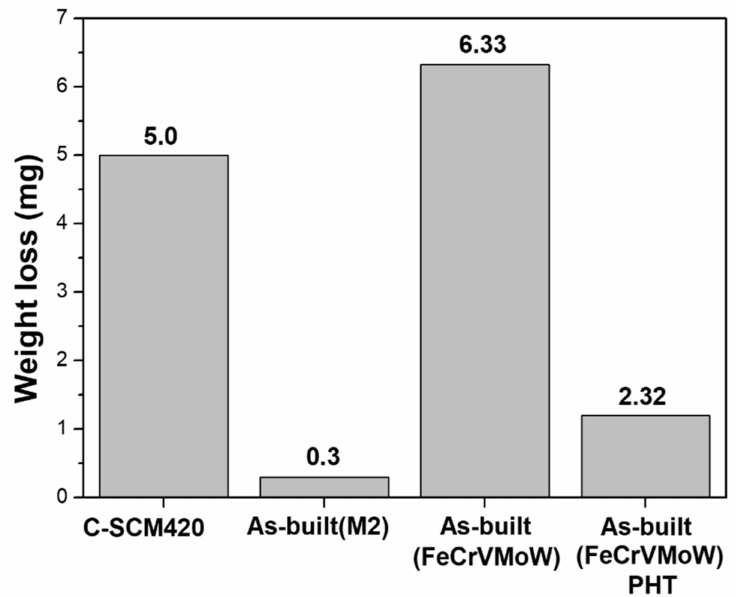
Figure 10. Comparison of weight loss of each